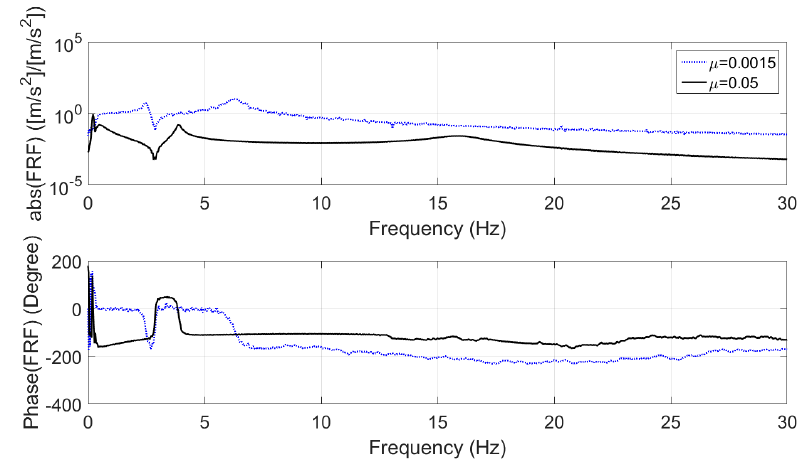
Figure 9. FRF in the horizontal direction between the seismic plate and the upper plate obtained from the updated model with two different fiction coefficients: µ = 0.0015 (blue dotted curve) and µ = 0.05 (black solid curve).